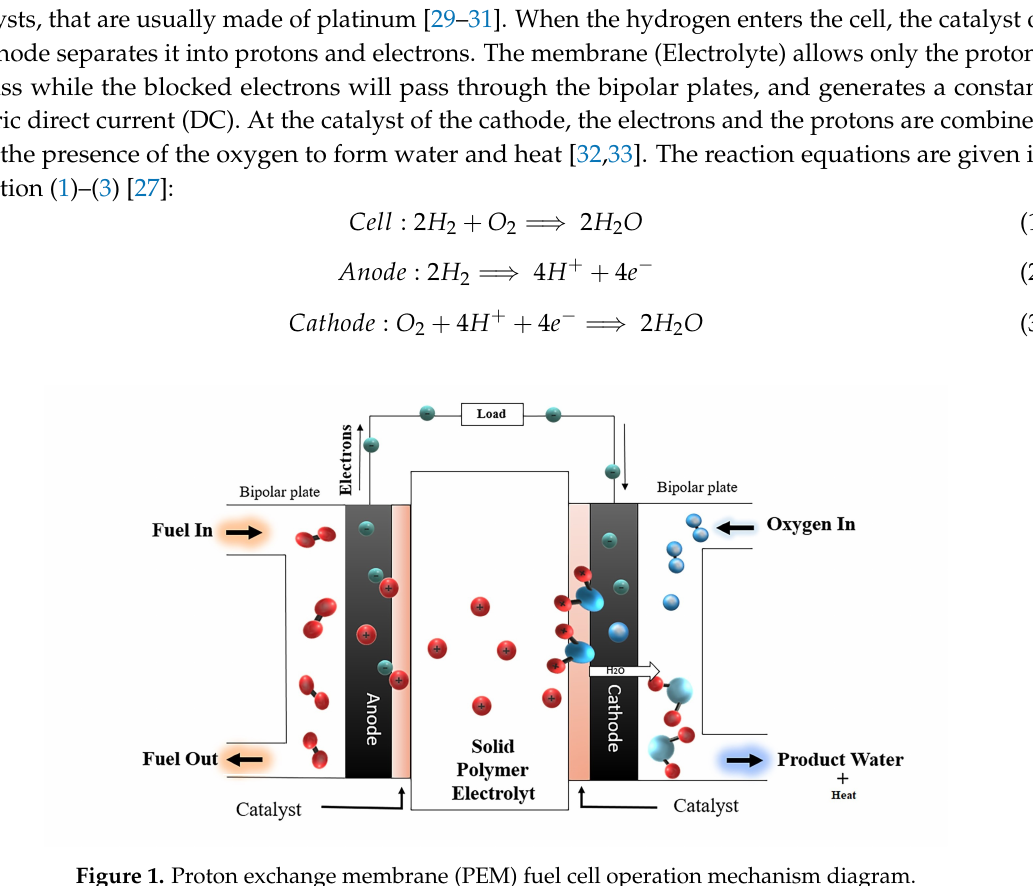
Figure 1. Proton exchange membrane (PEM) fuel cell operation mechanism